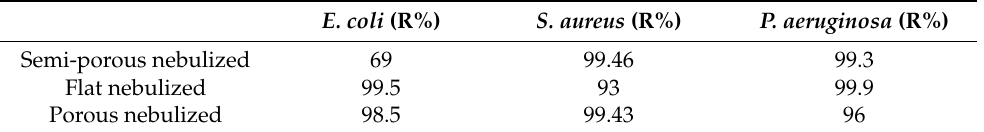
Table 2. The table shows the percentage of inhibition growth of mix of microorganisms on different surfaces, after nebulization with HOCl at 300 ppm. All the data reported are the average of three independent experiments conducted (each experiment) in triplicate. Mix Bacteria (R%) Semi-porous nebulized 99.9